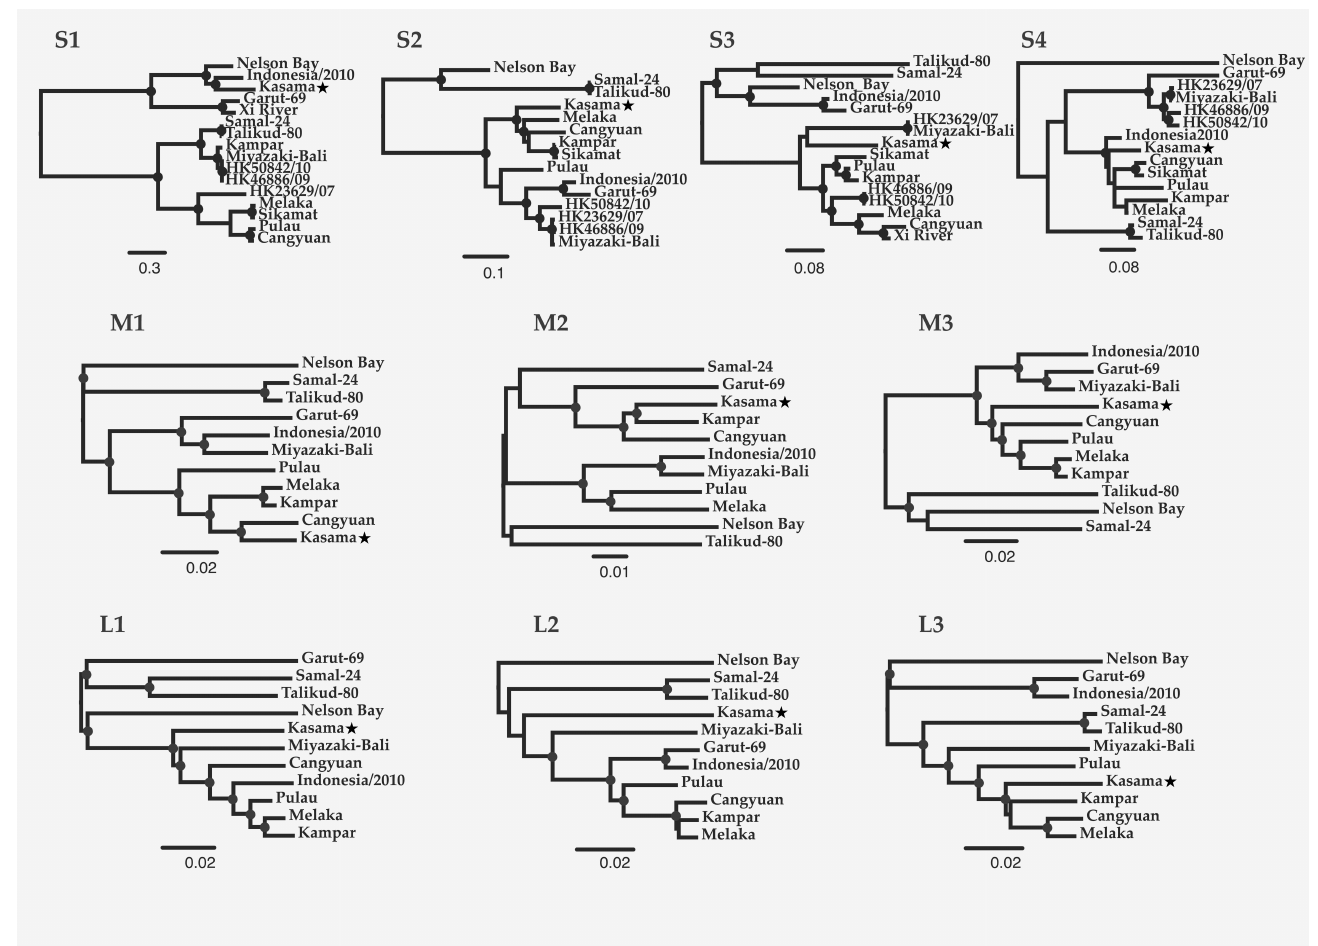
Figure 2. Maximum likelihood trees of the 10 PRV genome segments. The trees were constructed from codon-based alignments of open reading frames from each segment (GenBank Accession numbers in Supplemental Table S1), with molecular evolution model selection (GTR + + I) by PhyML smart model selection (BIC). Circles on nodes indicate > 75% confidence based on 1000 bootstrap replicates. The scale bar indicates nucleotide substitutions per